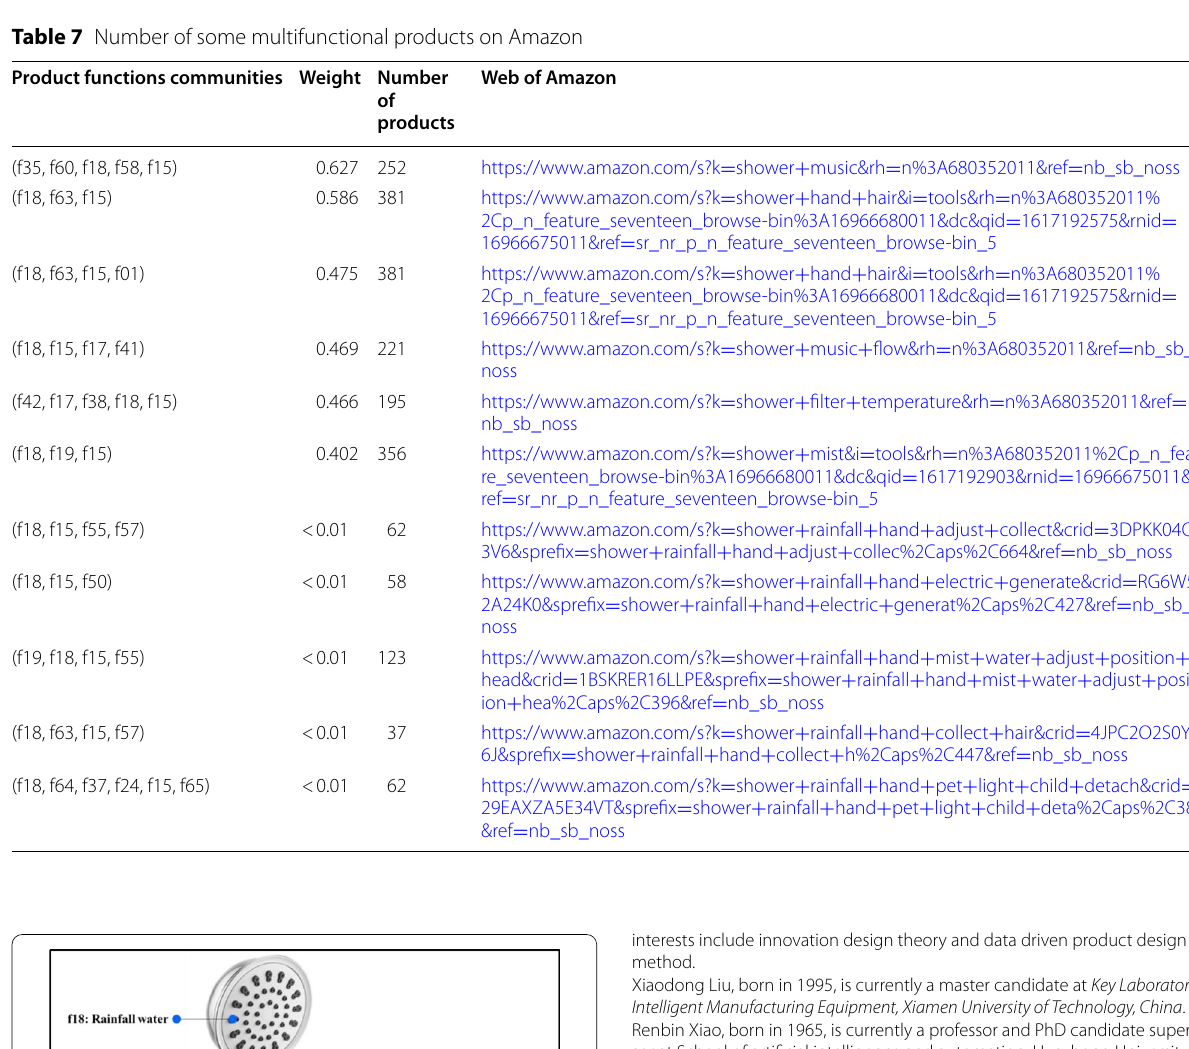
Table 7 Number of some multifunctional products on Amazon Product functions communities Weight Number